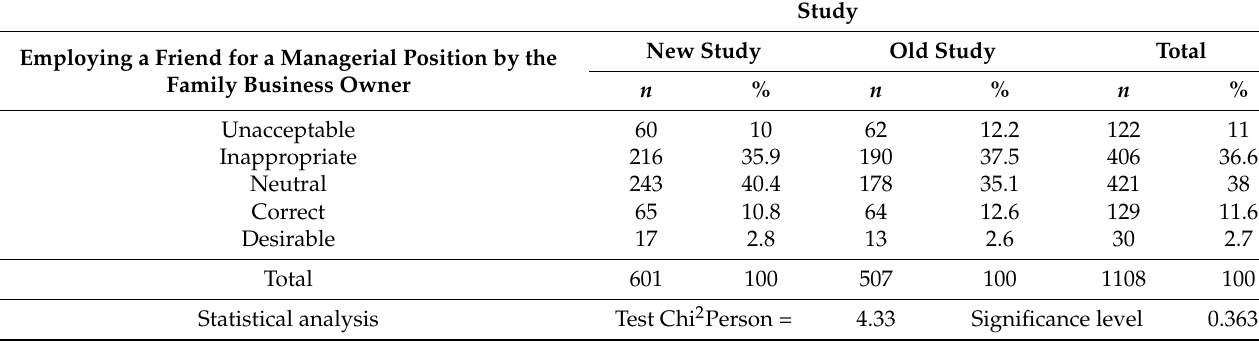
Table 13. Statistical analysis of the assessment of employment of a friend for a managerial position by the family business owner depending on the date of the study.